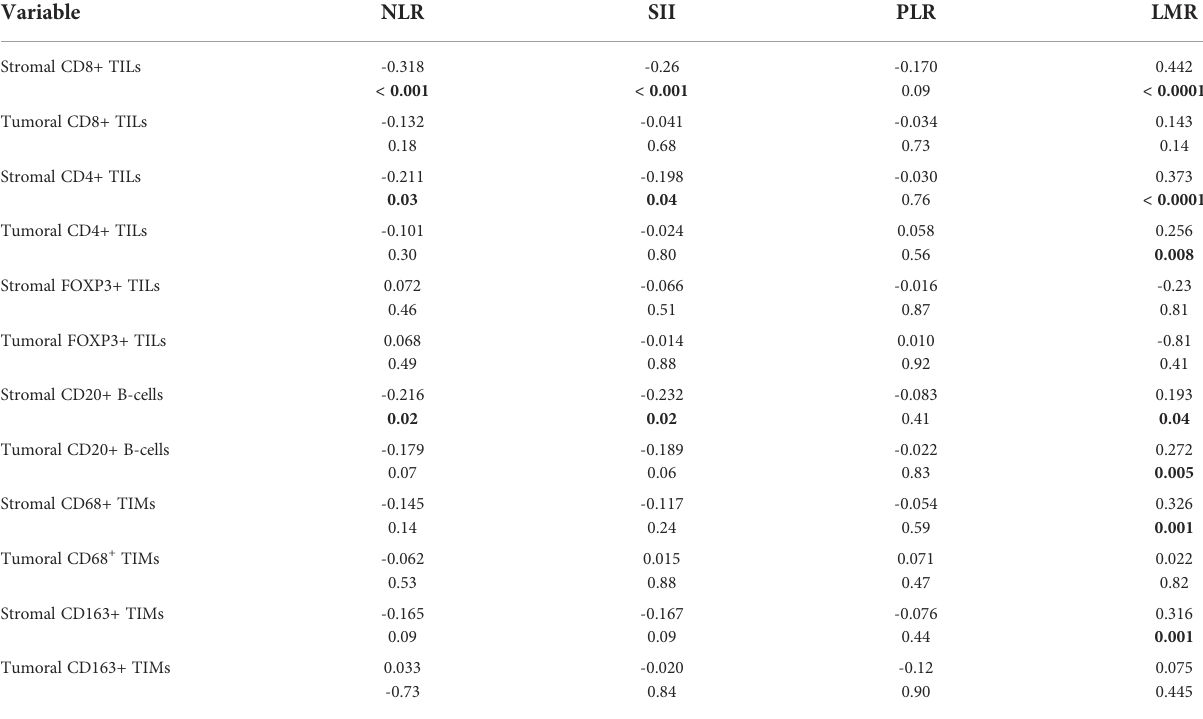
TABLE 6 Correlations between systemic NLR, SII, PLR, and LMR, and the immune tumor in fi ltrate in OSCC tissue samples from 119 patients.